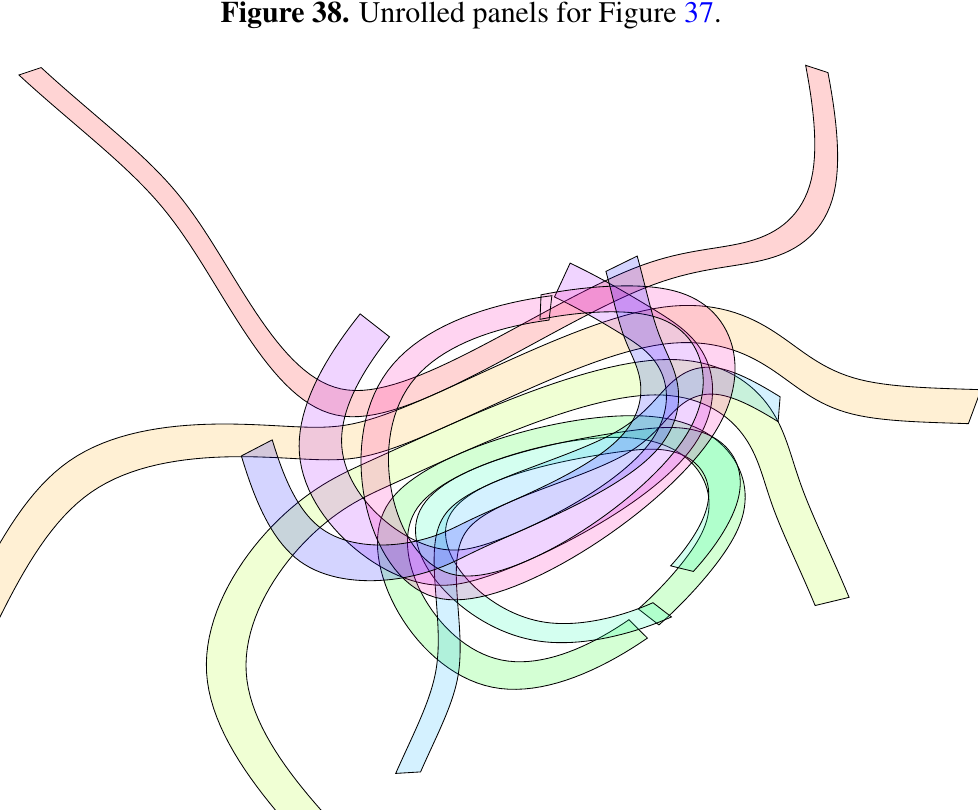
Figure 38. Unrolled panels for Figure